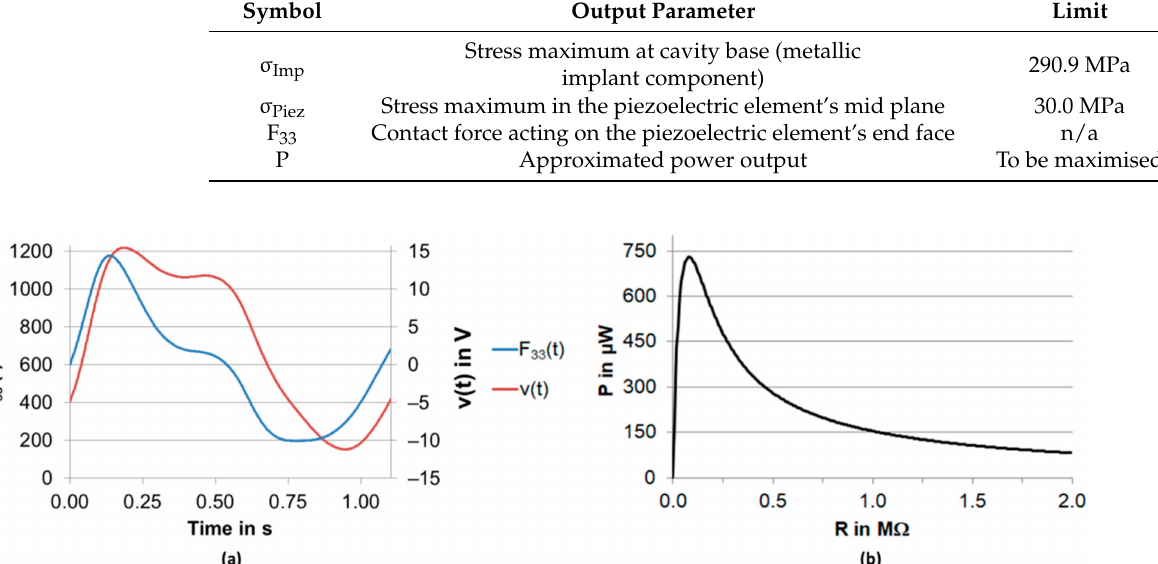
Figure 3. ( a ) Force profile of F 33 (t) acting on the piezoelectric element for the final design, scaled on the basis of Bergmann et al. [18] and our approach described in [15] (red) and the according calculated generated voltage for the best matching resistance R = 0.08 M Ω (blue). ( b ) Calculated power output according to Equation (2) for different load resistance R for the final design with a maximum of 729.9 µ W at R = 0.08 M Ω